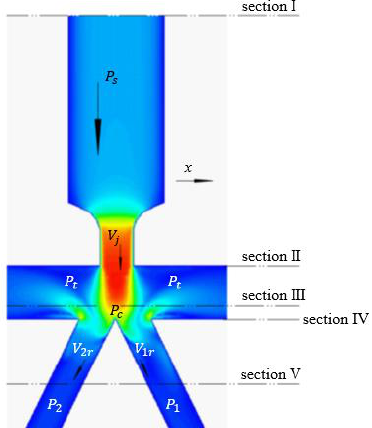
Figure 5. Velocity structure of the pilot stage.